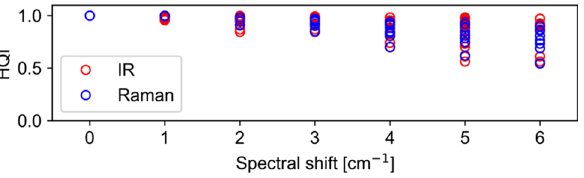
Figure 4. Robustness of HQI. The spectra are matching against themselves, shifted by the denoted wavenumbers (IR red, Raman blue symbols).